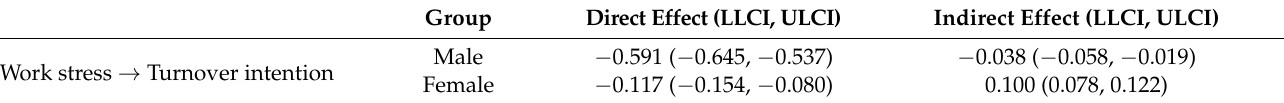
Table 2. Result of mediation effect: capabilities (direct, indirect). Group Direct Effect (LLCI,